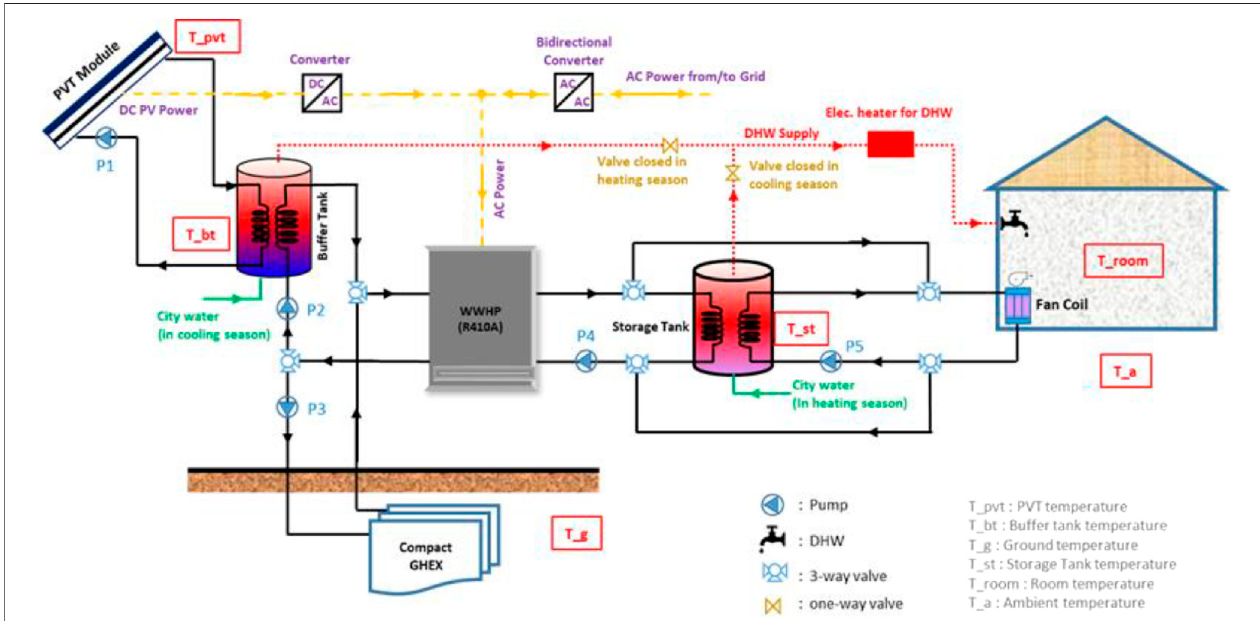
FIGURE 1 | Hybrid solar – geothermal heat pump polygeneration system concept.